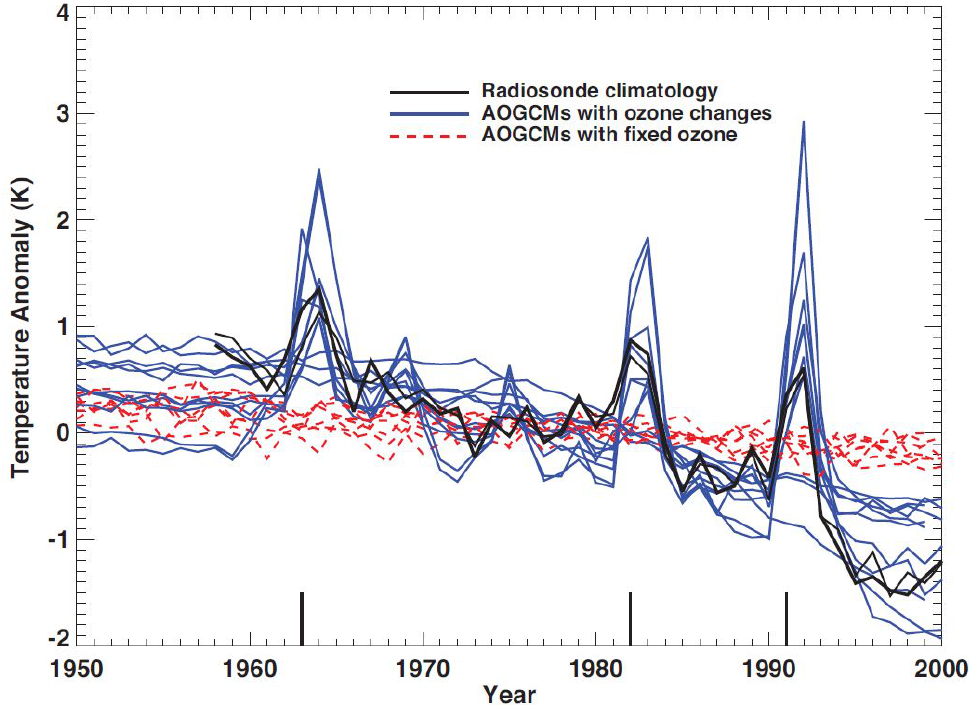
Figure 3. Time series of globally averaged annual temperature anomalies (K) at 50 hPa from radiosonde observations (black line) and AOGCM simulations (colored lines). Global climate model (AOGCM) simulations that included specified stratospheric ozone depletion, as well as increases in greenhouse gases and anthropogenic aerosols, are shown with blue lines, while model simulations that did not include stratospheric ozone depletion are shown with red dashed lines. Some, but not all, the models also include specified stratospheric volcanic aerosol amounts. Short vertical lines on the abscissa denote years of eruptive volcanic eruptions: Agung (1963), El Chichón (1982), and Pinatubo (1991). (Figures 4–15 in [2]; see also